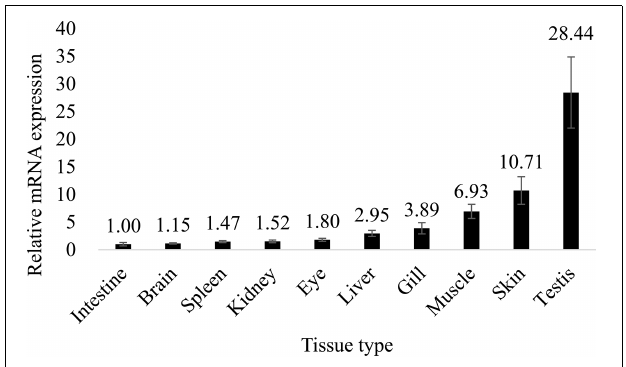
FIGURE 3 | Tissue distribution of ch25h in male Chinese tongue sole. Results were expressed as relative mRNA expressions to the lowest expression (means ± standard error, n = 6).